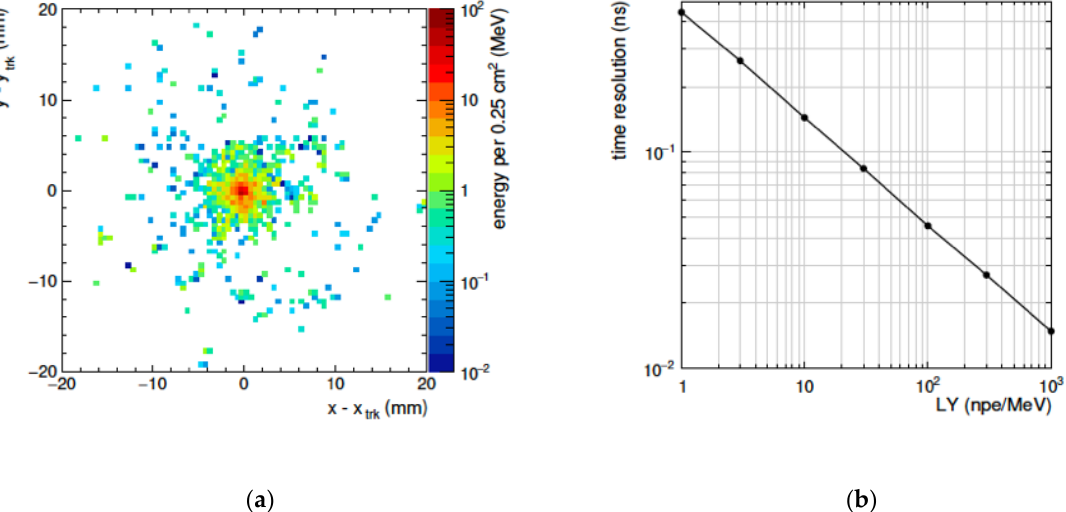
Figure 5. ( a ) Location of the energy in a RADiCAL module at shower max for 50GeV electrons in GEANT4 simulation. The module itself occupies a square region of 14 × 14 mm 2 at the center of the plot. ( b ) Timing resolution vs. detected light yield in photoelectrons per MeV, simulated for a 50 GeV electron shower. Downstream readout only in this GEANT4 simulation study.